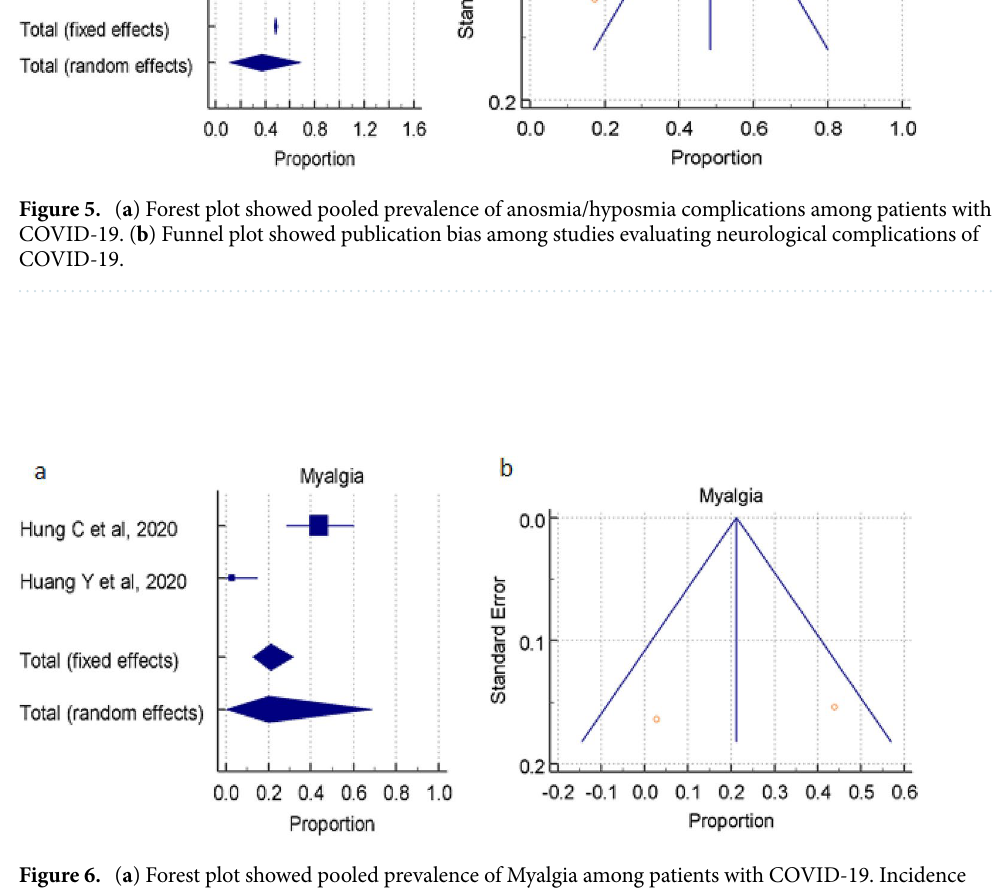
Figure 6. ( a ) Forest plot showed pooled prevalence of Myalgia among patients with COVID-19. Incidence of Myalgia symptoms. ( b ) Funnel plot showed publication bias among studies evaluating neurological complications of